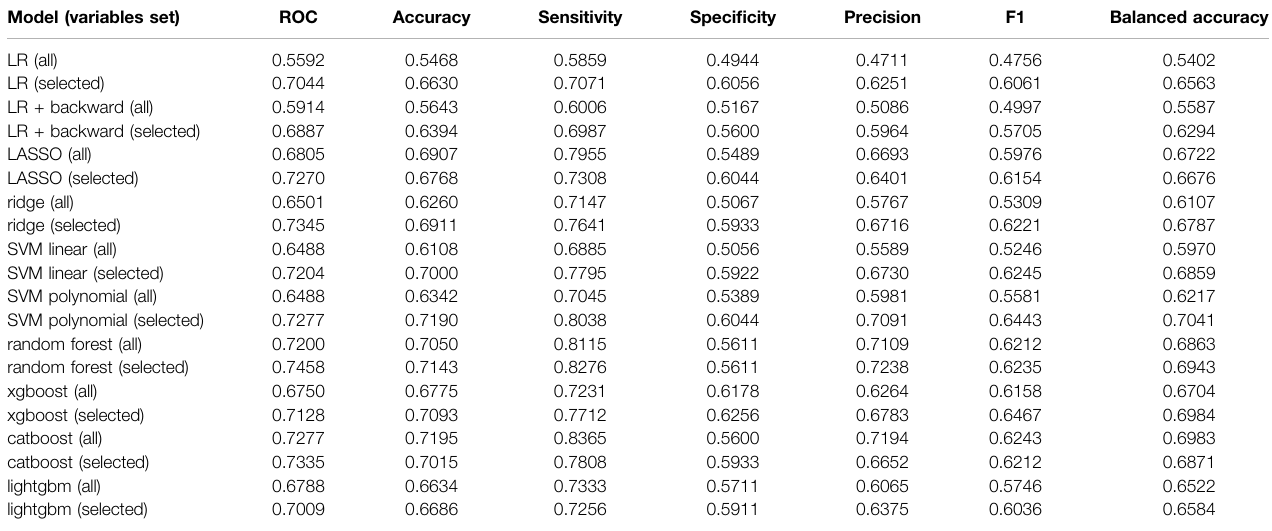
TABLE 1 | Summary of models ’ performance on a validation sample.